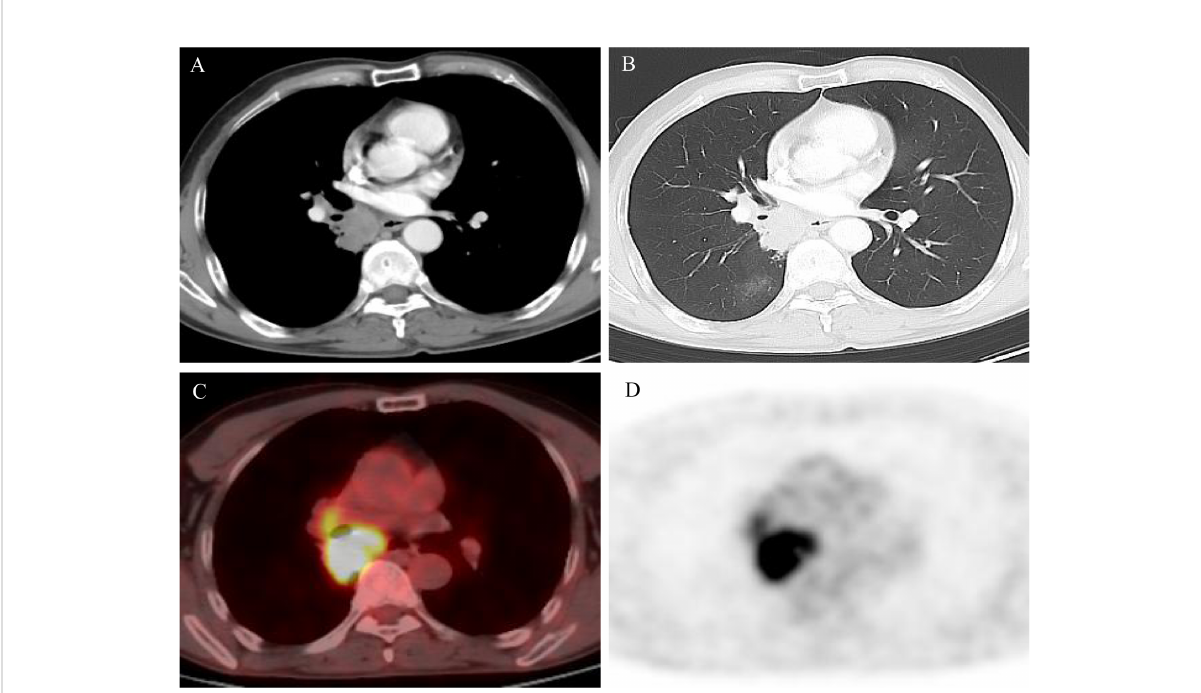
FIGURE 1 (A, B) Computed tomography (CT) scan at diagnosis showed a lung mass in the right lower lobe and mediastinum; (C, D) positron emission tomography/computed tomography (PET/CT) scan at diagnosis showed high fl uorodeoxyglucose avidity.